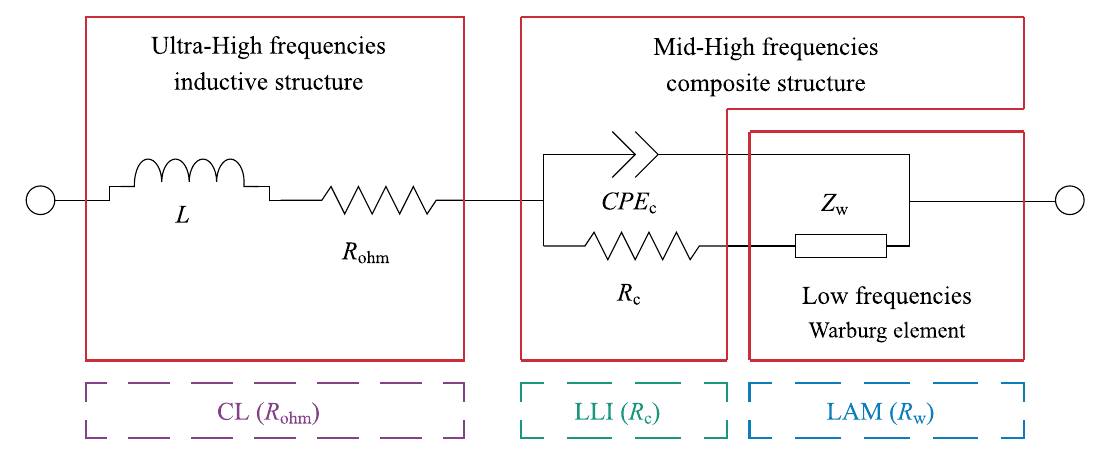
Figure 8. First-order equivalent circuit model.